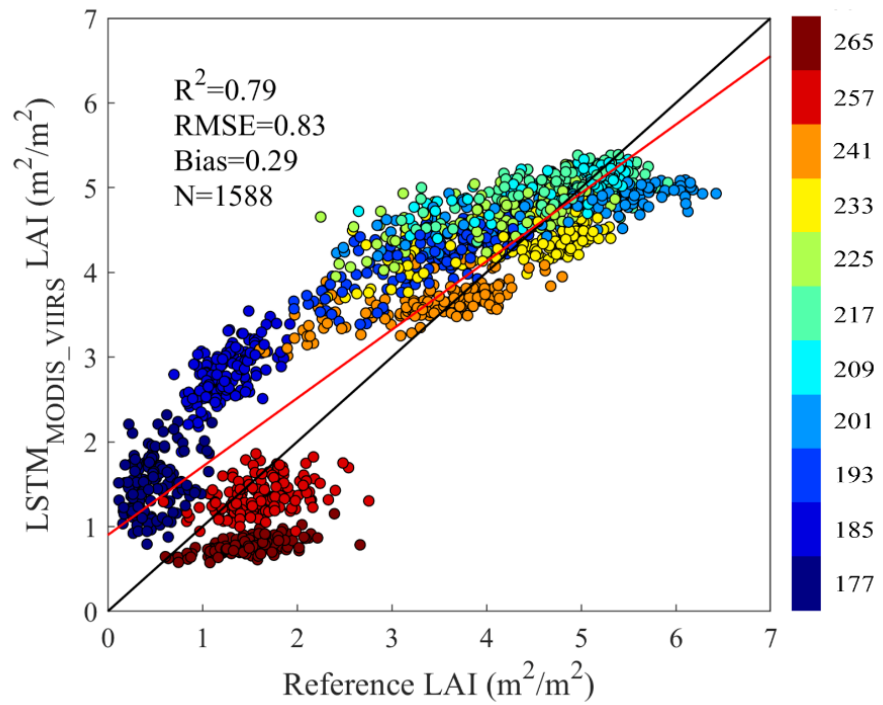
Figure 7. Accuracy assessment of the LSTM MODIS_VIIRS LAI values against the reference LAI.